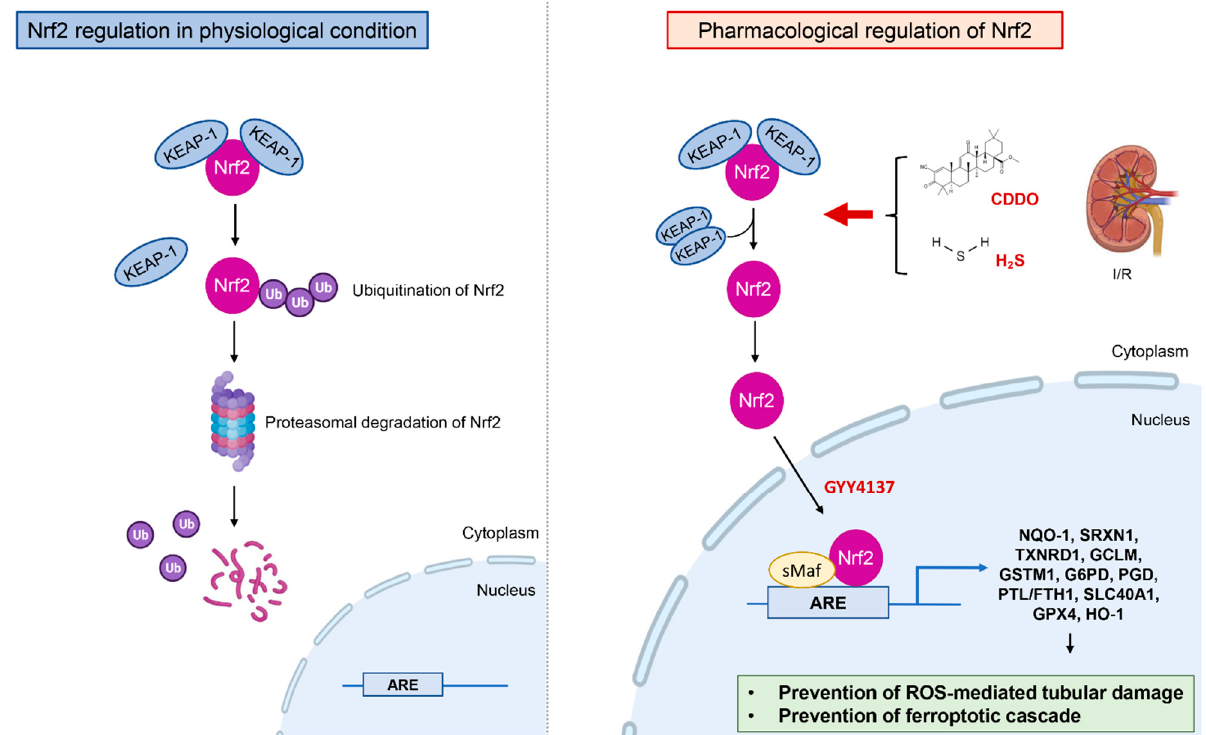
Figure 2. Mechanism of Nrf2 regulation in the treatment of renal I/R. In physiological condition Nrf2 binds to Kelch-like ECH-associated protein-1 (Keap1) in the cytoplasm and is degraded by ubiquitin-proteasome pathway. During renal I/R the hyperactivation of Nrf2 by CDDO, H 2 S, water-soluble H 2 S donor (such as GYY4137) leads to nuclear traslocation of Nrf2 that binds to antioxidant response elements and activates transcription of the genes encoding proteins involved in antioxidants mechanisms and iron metabolism thereby preventing the ROS-mediated tubular damage and the ferroptotic cascade.